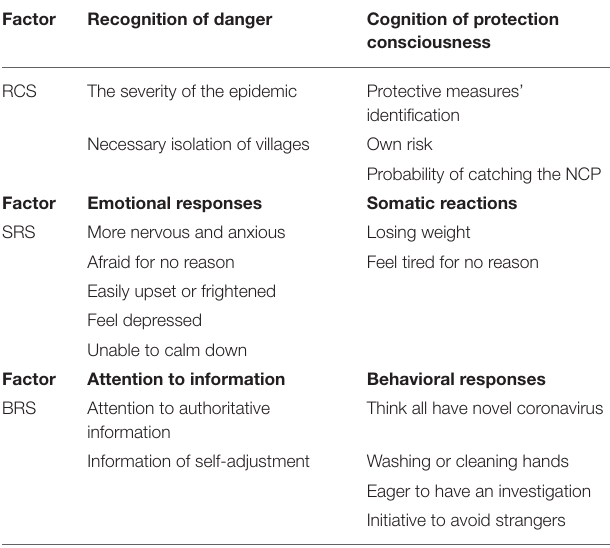
TABLE 5 | The structure of the RCS, SRS, and BRS.